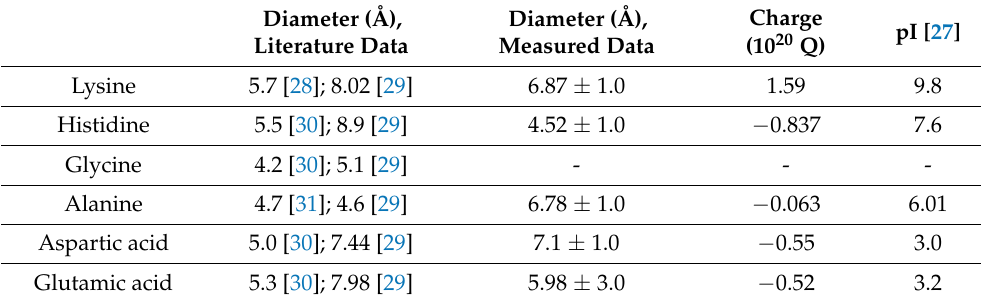
Table 1. Diameters, charges and pI values of amino-acids under